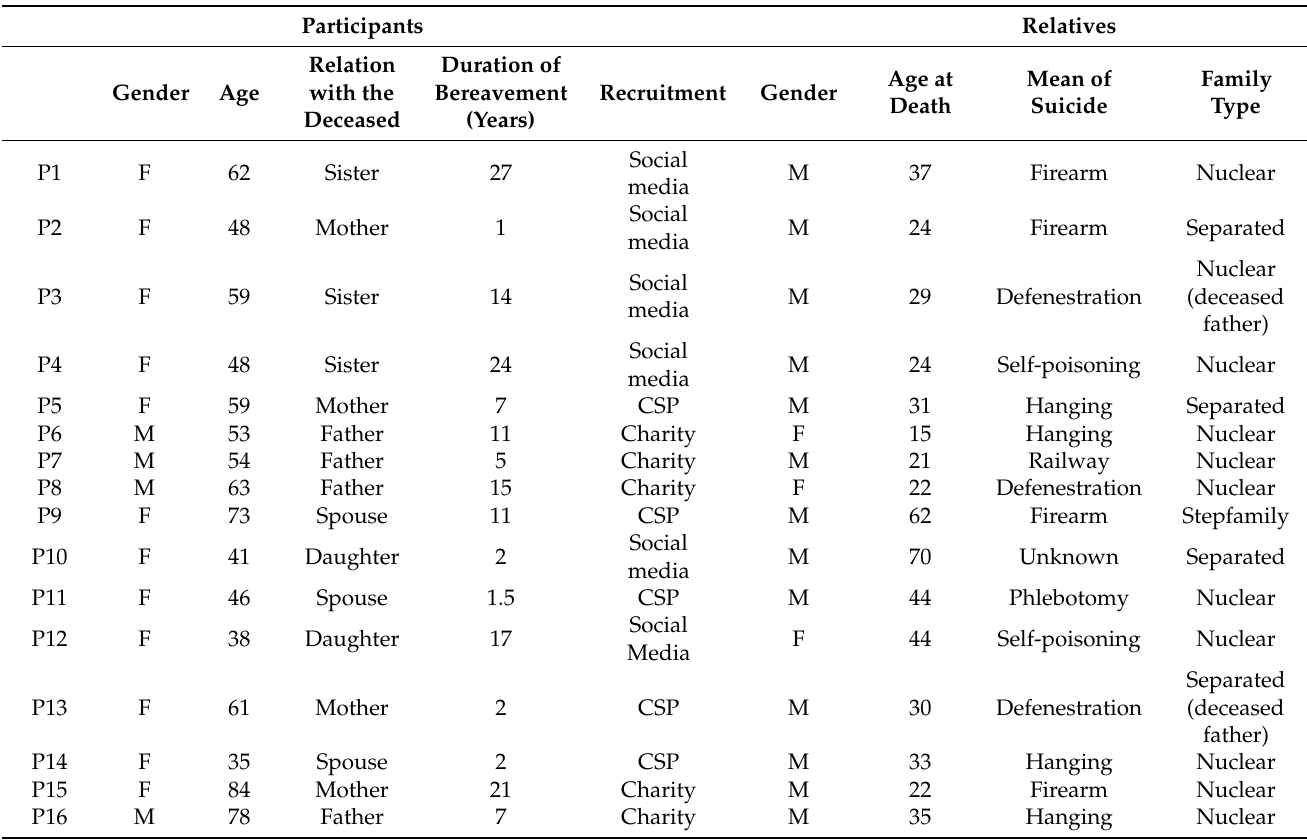
Table 2. Characteristics of the participants and of their relatives who died by